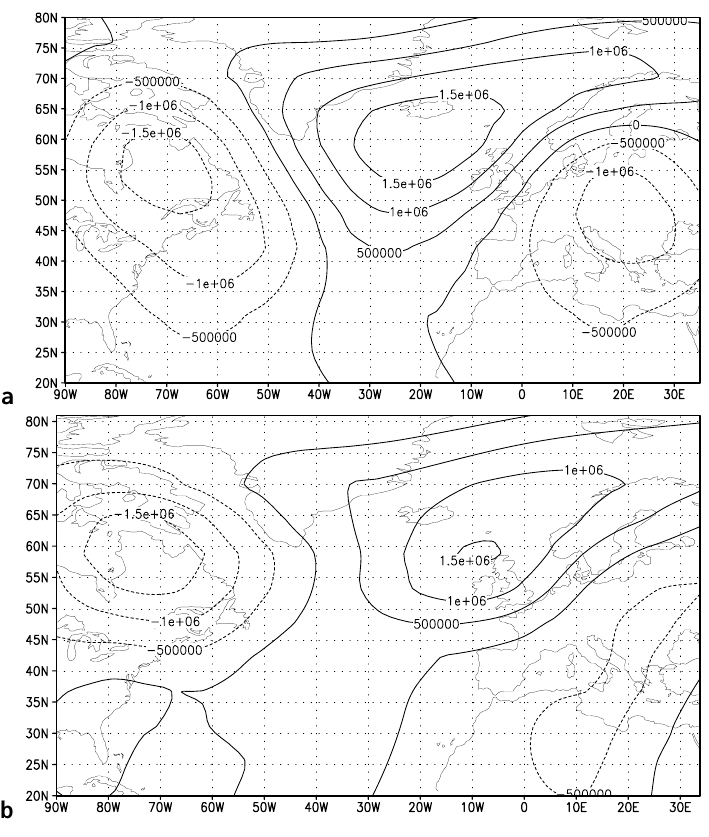
Fig. 3. Stream function anomaly 9 (m 2 s − 1 ) : (a) target pattern in the data assimilation, and (b) mean difference in winter (DJF) between the data assimilated run and the control run.